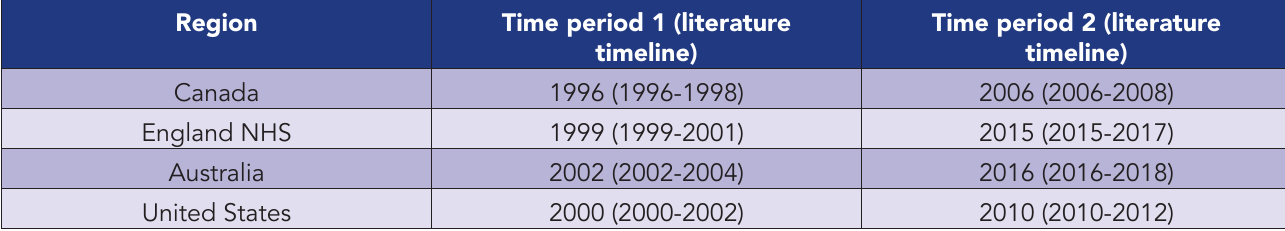
Table 5: Countries and time periods of